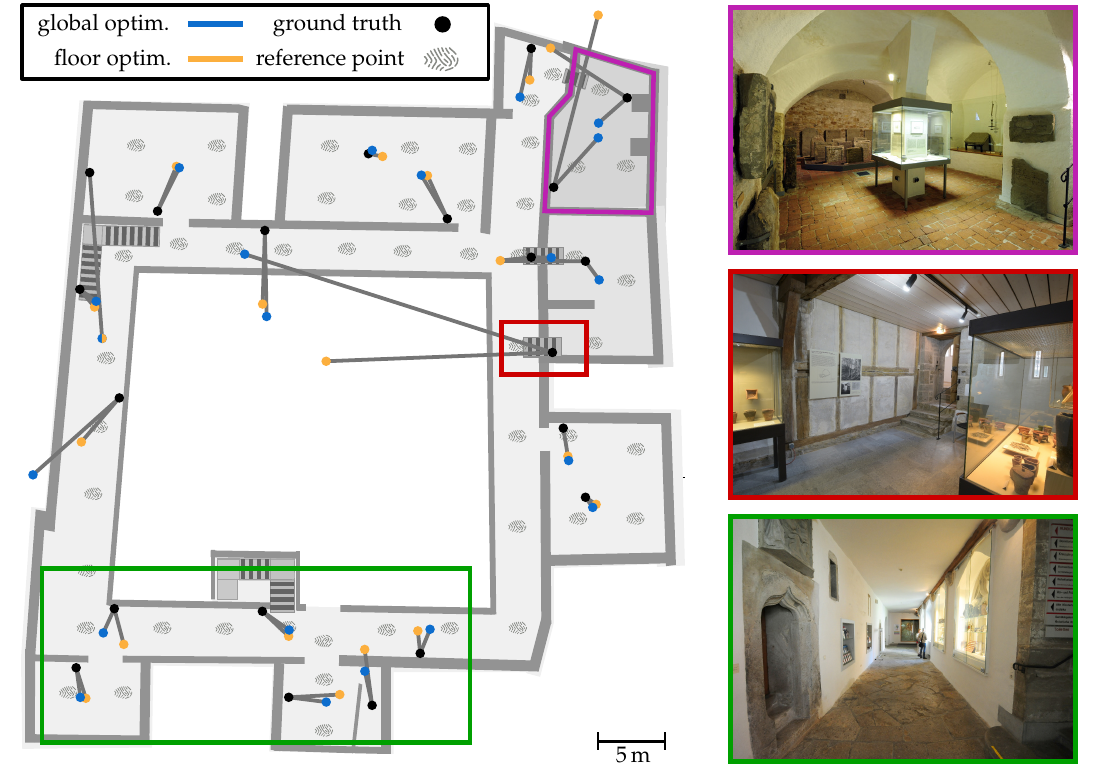
Figure 7. Ground level of the building in the xy -plane from above. Includes the locations of the reference points, the ground truth and the optimized APs. The grey line connects an AP with the corresponding optimization. The colored borders are areas of special interest and are discussed within the text. The corresponding pictures on the right side show the museum in these